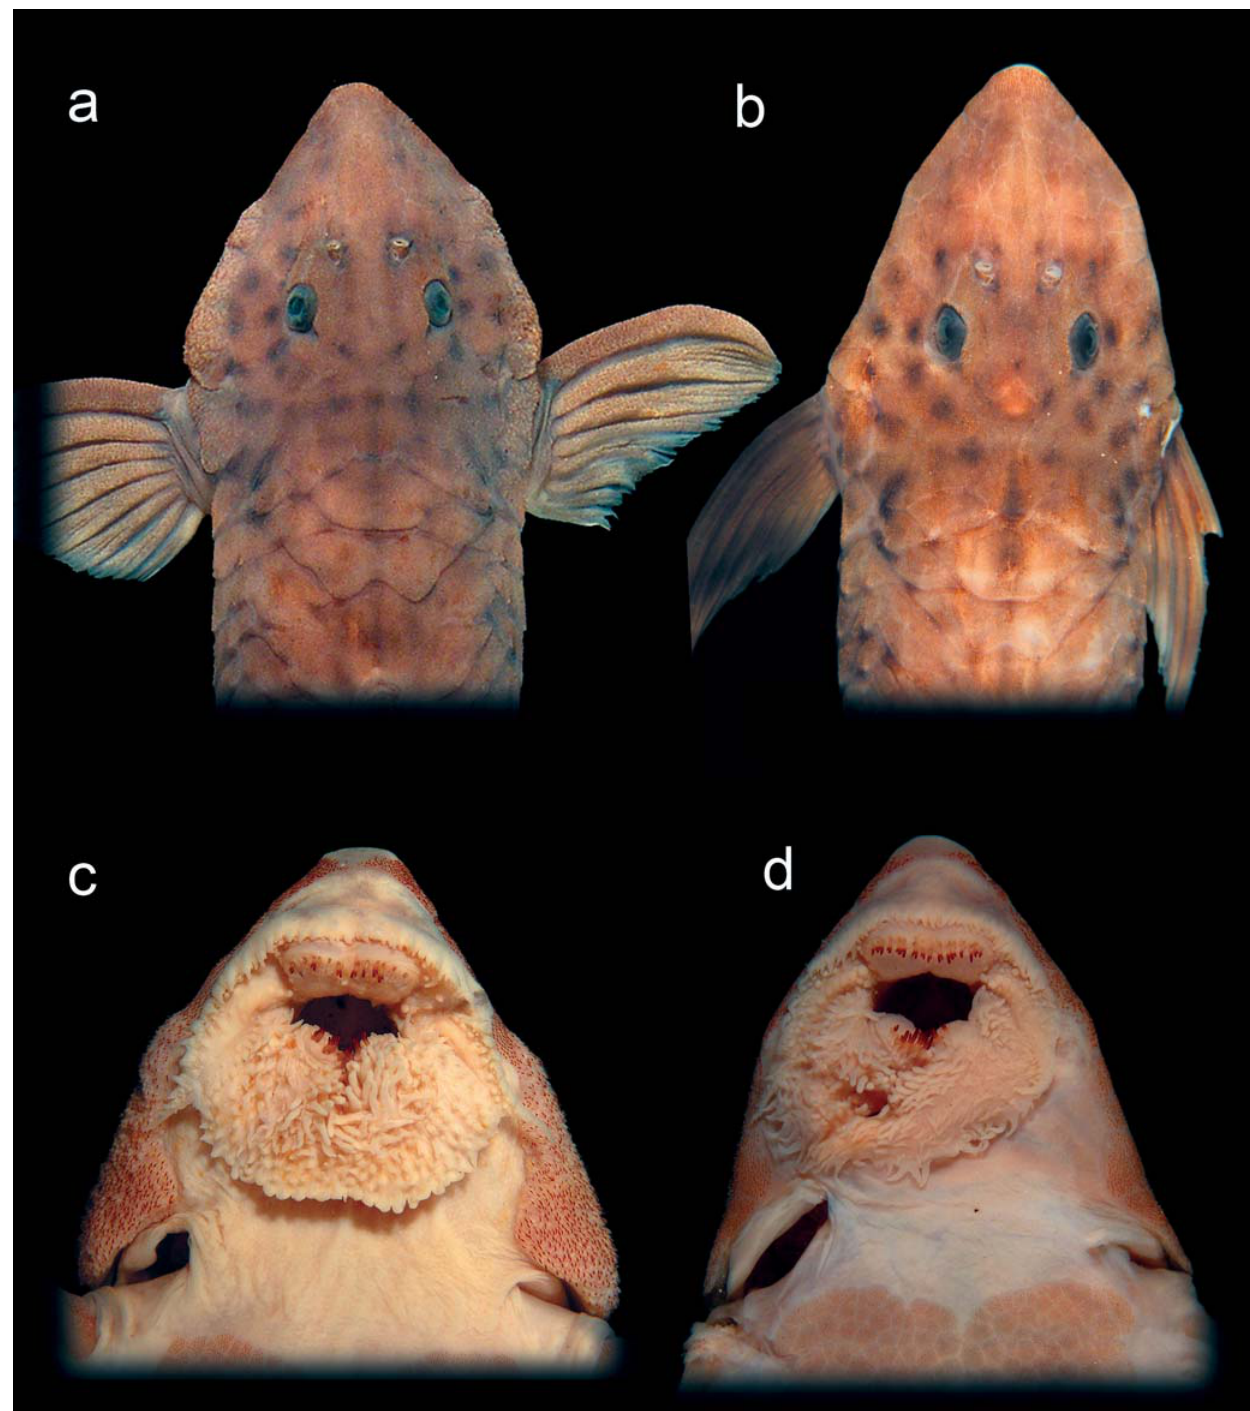
Fig. 3. Rineloricaria daraha . Paratypes. Dorsal and ventral detail of head of sexually dimorphic male ( a and c = INPA 6586; 186.8 mm SL) and female ( b and d = INPA 6586; 131.2 mm